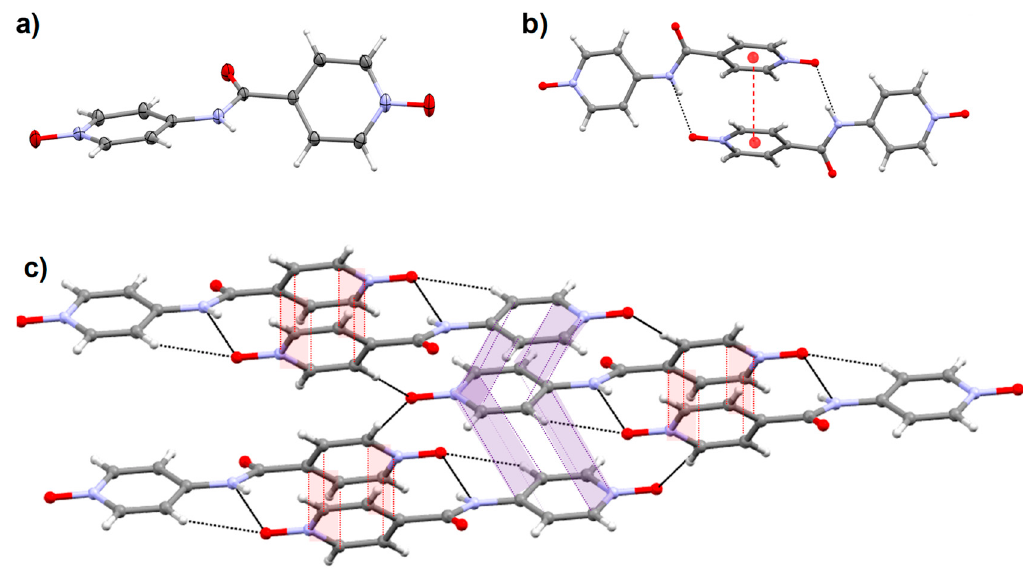
Figure 3. ( a ) Crystal structure of diNO , ( b ) showing hydrogen-bonded dimer stabilized with π – π interaction and ( c ) interaction of the individual dimer with adjacent dimer via various non-bonding interactions (dotted lines); black lines indicate hydrogen bonding, red line for π – π interactions of the individual dimer, and blue line for π – π interactions with adjacent dimers.